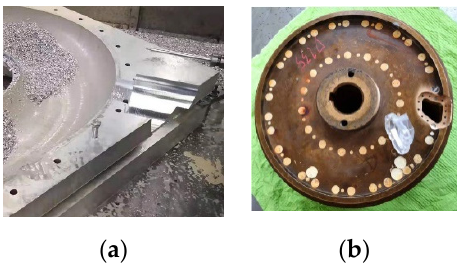
Figure 1. Observation window: ( a ) spiral casing; ( b ) runner.